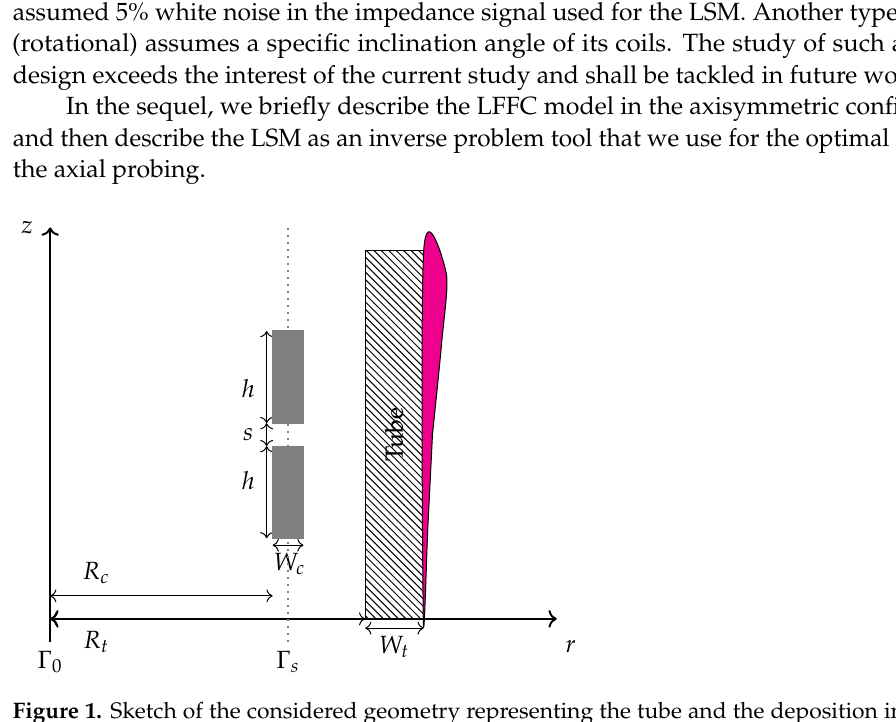
Figure 1. Sketch of the considered geometry representing the tube and the deposition in the shell side, in an axisymmetric configuration. The probe is represented with two rectangles standing for two coils with height h and spaced with distance s . The W c and the R c stand for the coil width and radius, respectively. Γ s stands for the source term position where the coils will scan the whole tube through a